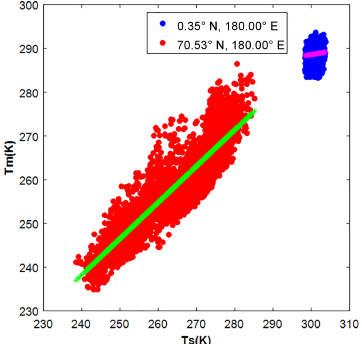
Figure 3. T s – T m scatter plots at two locations: (blue dots) 0.35 ◦ N 180.00 ◦ E and (red dots) 70.53 ◦ N 180.00 ◦ E. The magenta and green lines are their linear fitting curves. Temperature unit is